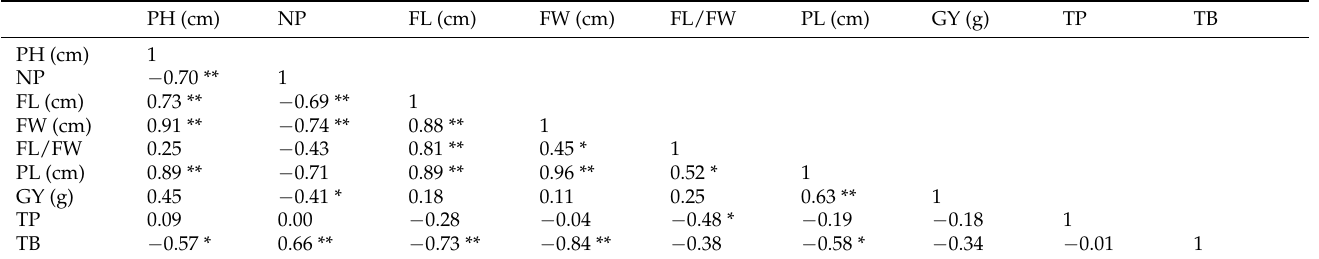
Table 2. Correlative coefficients among different agronomic traits of IL-J85.